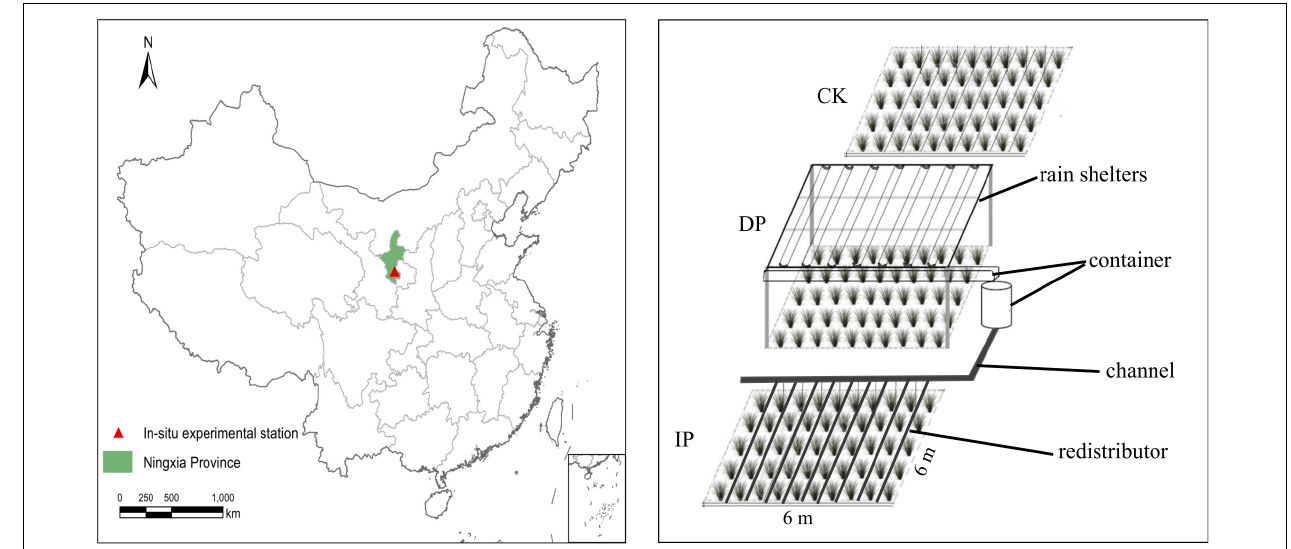
FIGURE 1 | Schematic diagramof study area and experiment